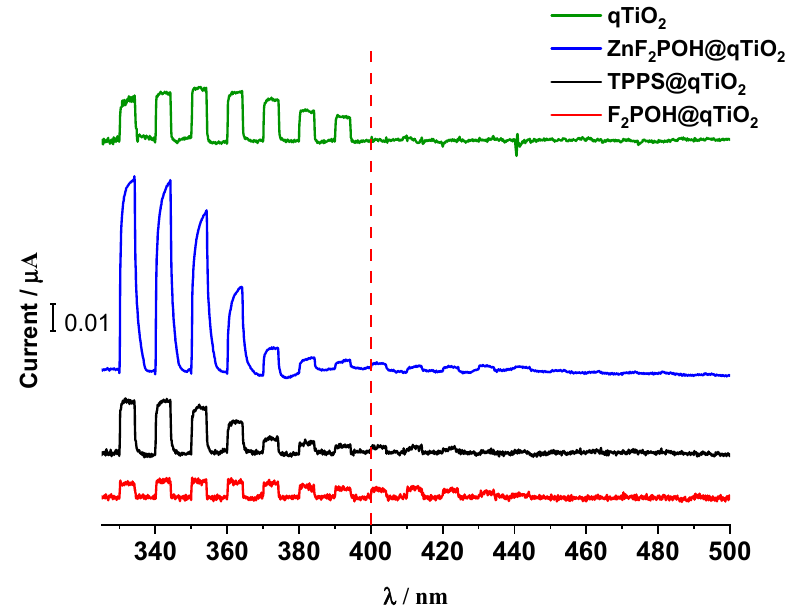
Figure 6. The photocurrent measurements as a function of the wavelength of incident light for sulfonated porphyrin (TPPS) and halogenated derivatives F 2 POH@qTiO 2 , ZnF 2 POH@qTiO 2 adsorbed at the surface of TiO 2 , as well as bare qTiO 2 as reference at the potential of 1000 mV vs. Ag /